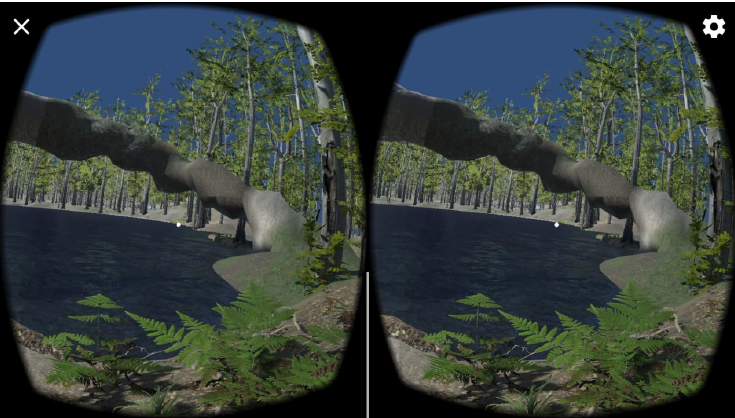
Figure 2. Visualization environment of AIVE.